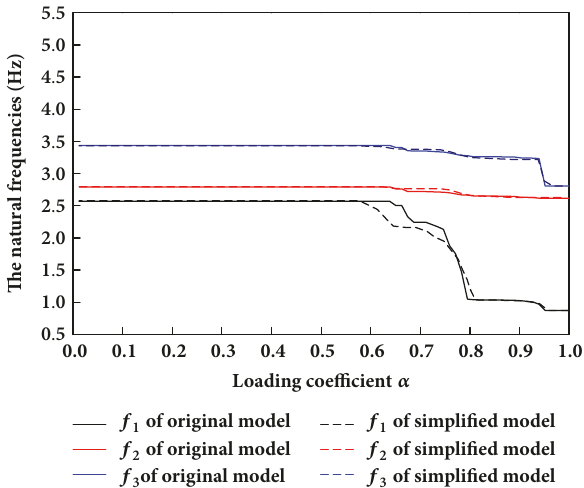
Figure 5: Variation of the natural frequencies of the three-storey eccentric structure with 𝛼